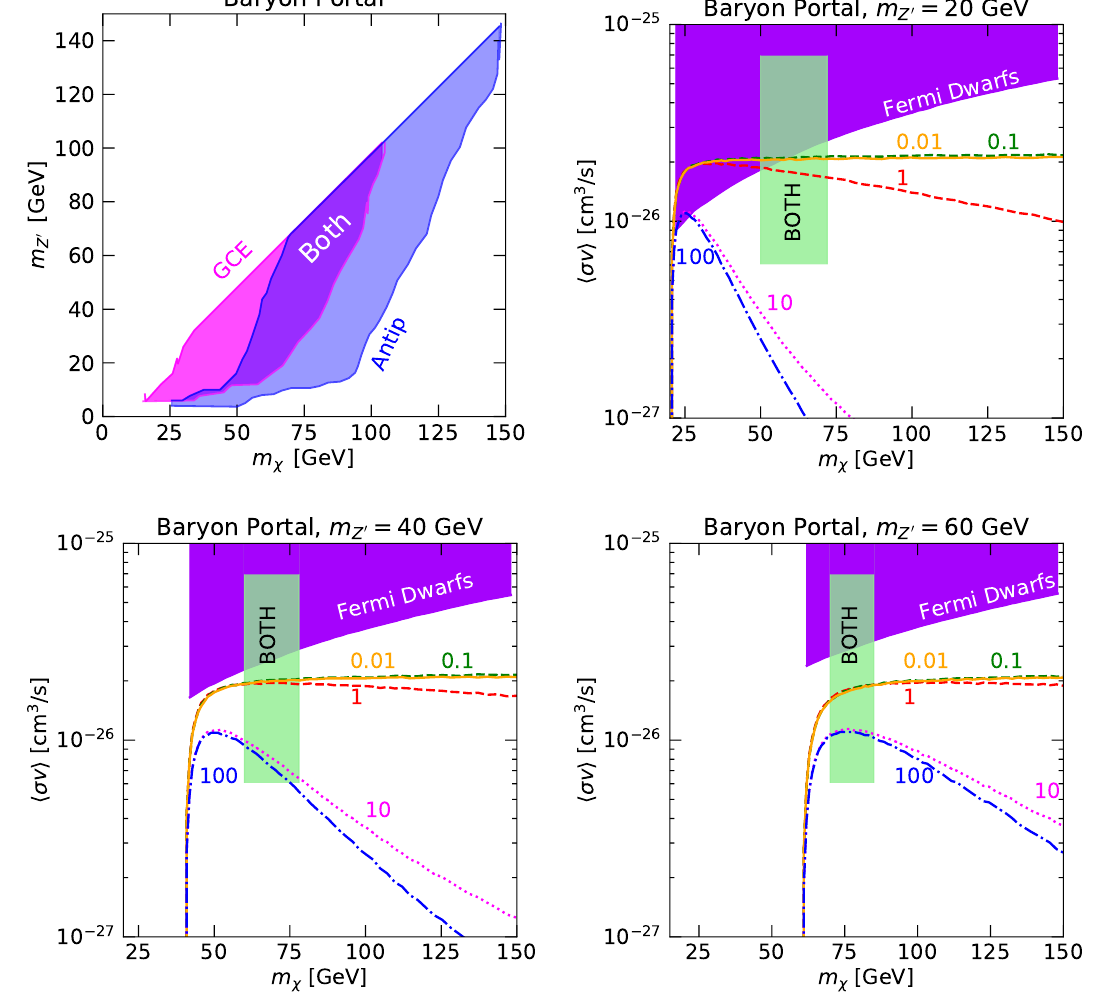
Figure 7 . As in (cid:12)gure 5, but for the case of hidden sector dark matter that annihilates to particles that decay through the baryon